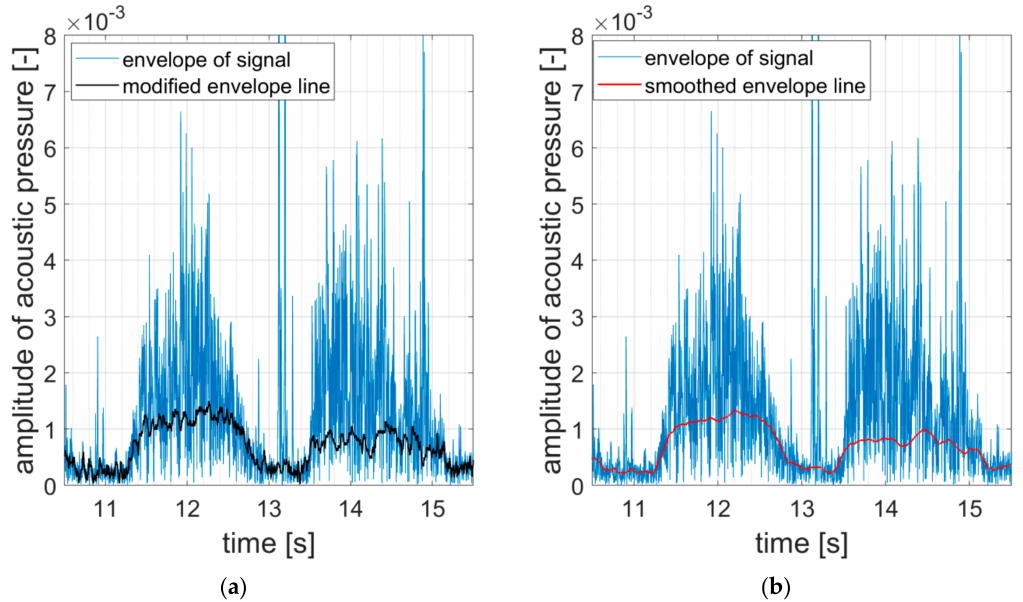
Figure 6. ( a ) Detail of modified envelope line with the elimination of the noise at the time of 13 s; ( b ) detail of smoothed modified envelope